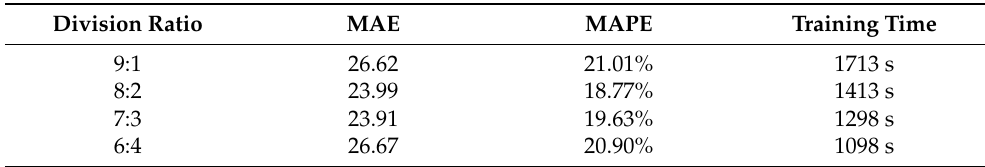
Table 5. Evaluation of model performance with different data division ratio with lstmunits set to 32 and epochs set to